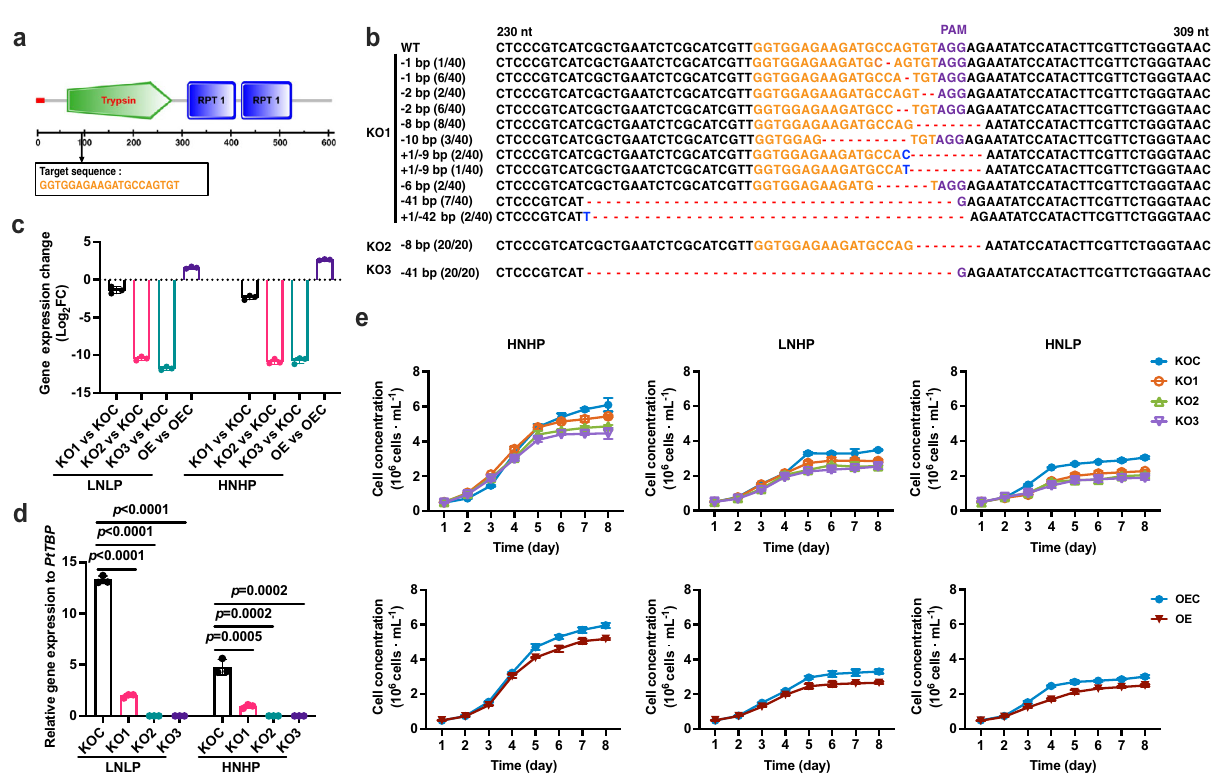
Fig. 4 Mutation generations of PtTryp2 and characters of mutants. a Schematic presentation of PtTryp2 protein. The target site (vertical arrow) for CRISPR/Cas9 -based knockout is located within the conserved functional domain (green pentagon), with PAM motif shown in orange font. Red rectangle on the left depicts signal peptide; RPT: internal repeat 1; b Alignment of partial PtTryp2 sequences of the CRISPR/Cas9 -generated mutants showing frameshift indels compared to wild type. The frequency by which the sequence was detected within the same colony is indicated in parenthesis. Font color coding: Black, WT sequence; Orange, functional domain containing target for CRISPR/Cas9 ; Purple, PAM sequence; Blue, Inserted bases; Red dashes, deleted bases. c PtTryp2 expression patterns of knockout and overexpression mutants under different conditions. FC fold change. Data are presented as mean values ± SD ( n = 3 biologically independent samples). d PtTryp2 expression of knockout mutants exhibited no response to ambient N and P fl uctuation. Data are presented as mean values ± SD ( n = 3 biologically independent samples). The comparisons between the averages of the two groups were evaluated using the one-tailed Student ’ s t test. The p values with signi fi cance ( p ≤ 0.05) are shown. e Growth curves of different PtTryp2 mutants under different N and P conditions. Nutrient conditions in c – e are indicated by HNHP (Nutrient-replete), LNHP (N-depleted, P-replete), HNLP (N-replete, P- depleted), and LNLP (Nutrient-depleted). Data are presented as mean values ± SD ( n = 3 biologically independent samples). Source data are provided as a Source Data fi